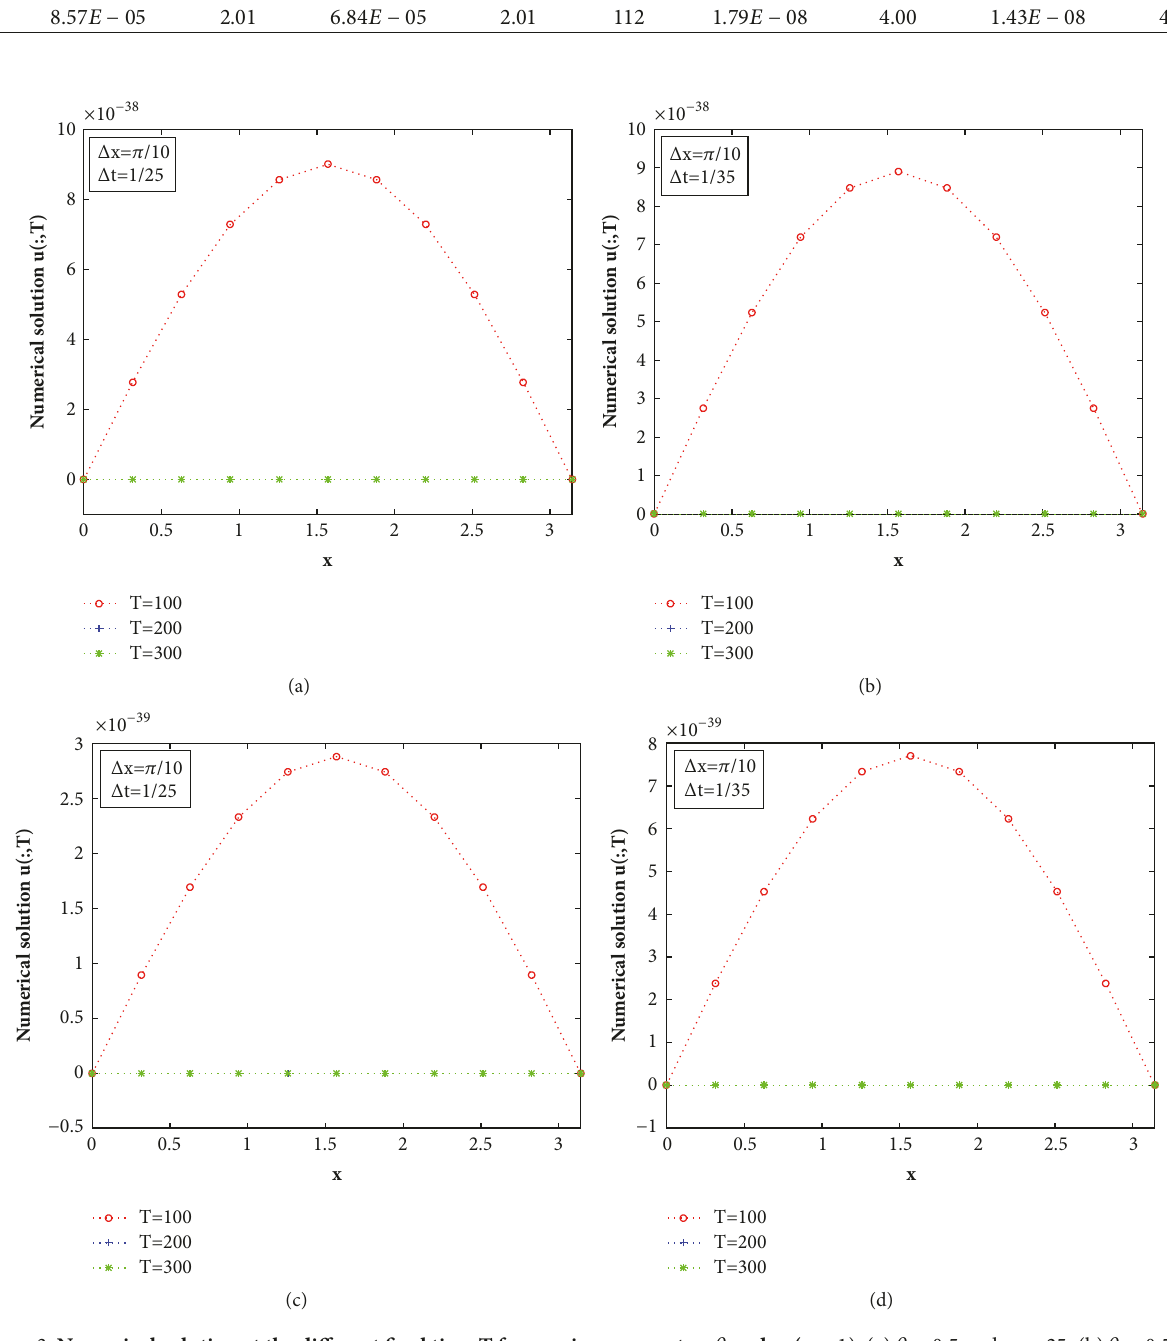
Figure 3: Numerical solution at the different final time T for varying parameters 𝜃 and 𝑚 ( 𝜏 = 1 ). (a) 𝜃 = 0.5 and 𝑚 = 25 . (b) 𝜃 = 0.5 and 𝑚 = 35 . (c) 𝜃 = 1 and 𝑚 = 25 . (d) 𝜃 = 1 and 𝑚 = 35